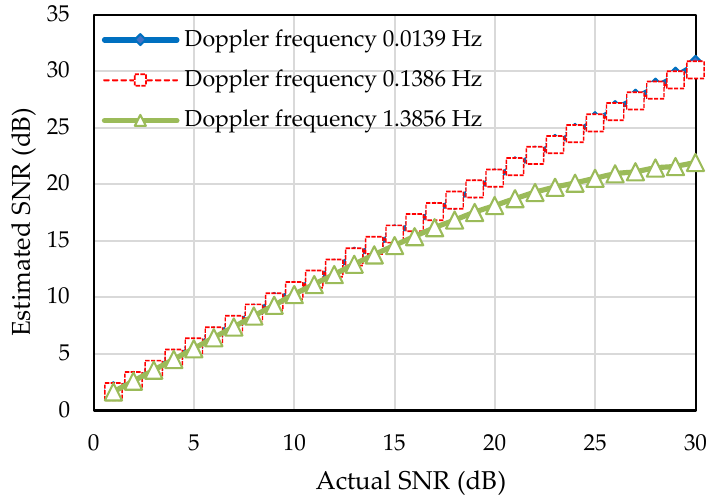
Figure 7. Estimated SNR for different Doppler frequencies for fixed modulation.